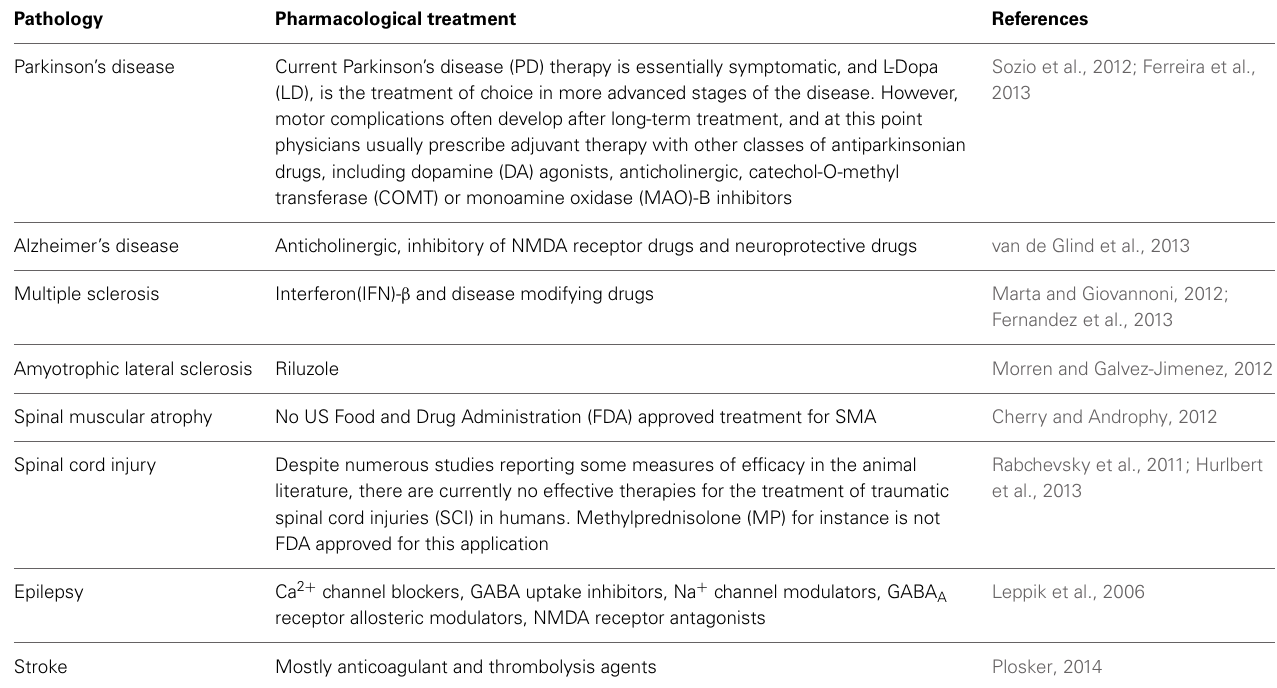
Table 1 | Pharmacological treatments of the common neurological